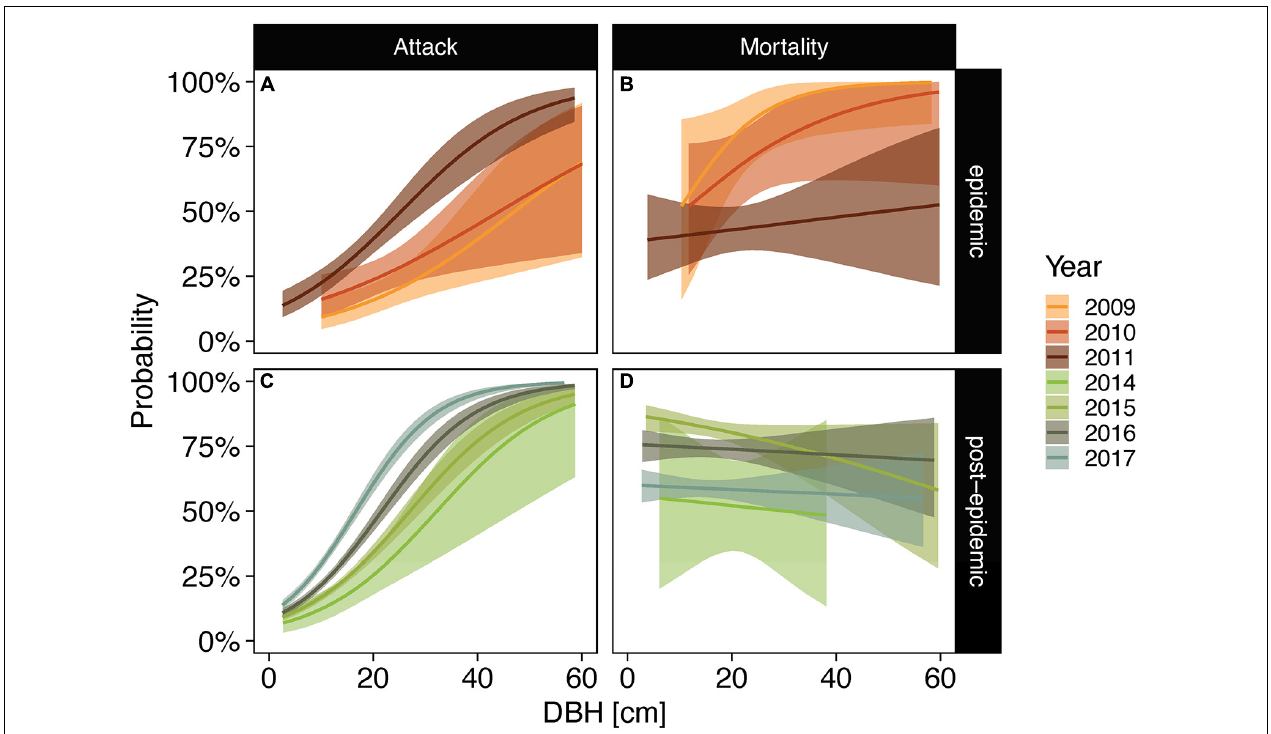
FIGURE 5 | Posterior probabilities of subalpine fir trees exhibiting signs of bark beetle attack (A,C) and bark beetle caused mortality following attack (B,D) in epidemic years [2008–2011; (A,B) ] and post-epidemic years [2014–2017; (C,D) ] as a function of diameter at breast height (DBH). Note that the years 2012 and 2013 had too few samples for subalpine fir and were thus excluded from the model. Lines represent posterior medians and bands represent the 94% credible intervals.